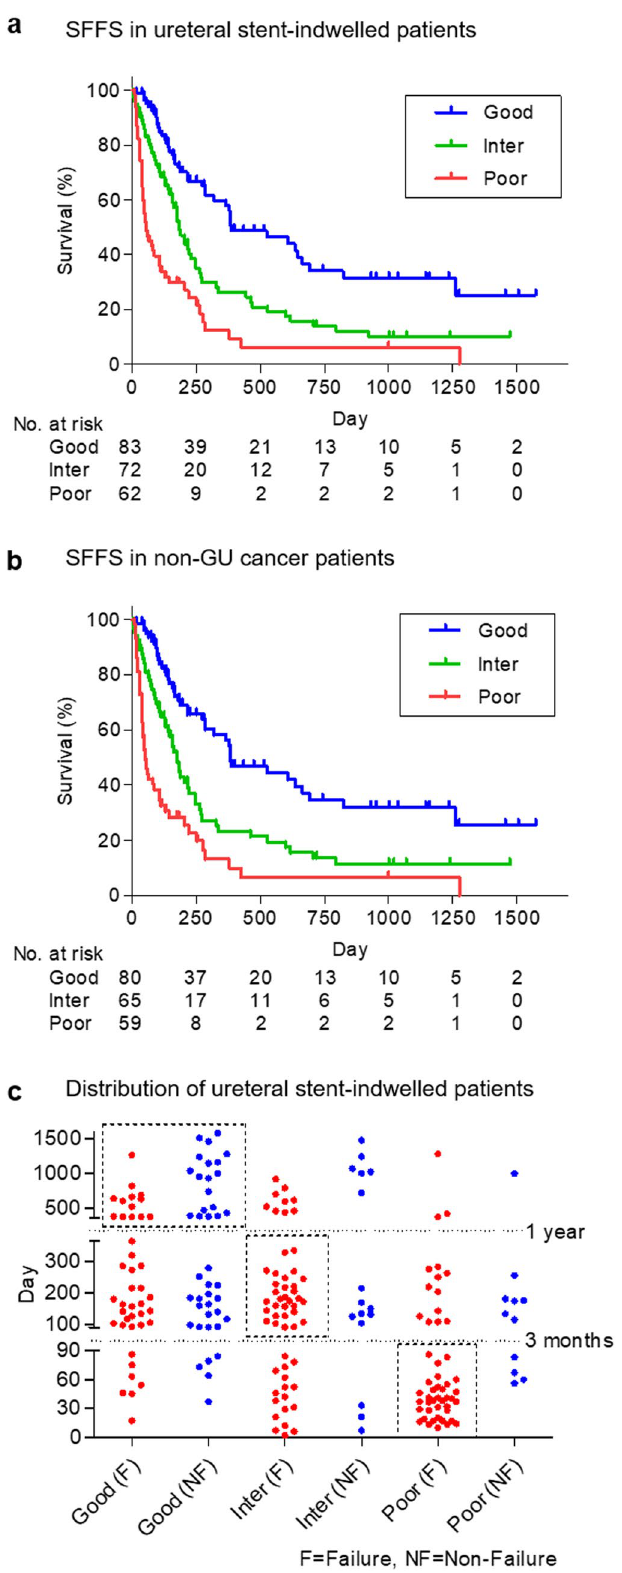
Figure 4. Stent failure-free survival of risk groups according to PLaCT risk classification. ( a ) Stent failure-free survival (SFFS) in overall patients ( P < .0001). ( b ) SFFS in non-genitourinary (GU) cancer patients ( P < 0.0001). ( c ) Distribution of SFFS in overall patients with boundaries of 3 months and 1 year. Although half of patients in the good risk group remained stent failure-free over 1 year (left upper square), most patients in the intermediate (Inter) and poor risk groups experienced stent failure between 3 months and 1 year (middle square), and within 3 months (right lower square), respectively. Statistical analyses were performed using GraphPad Prism 5 (https ://www.graph